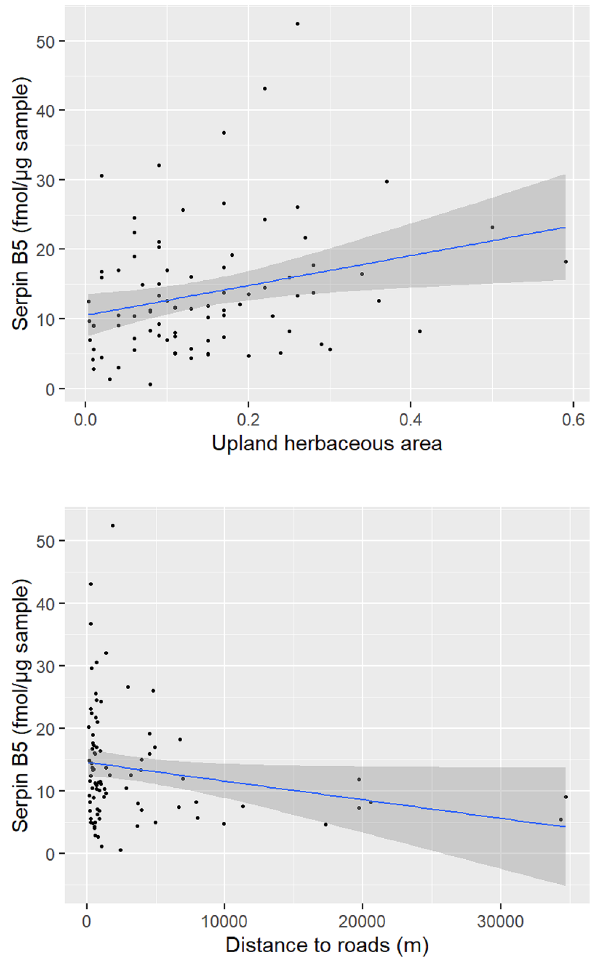
Figure 4. Estimated expression (solid blue line) of serpin B5 related to the distance to upland herbaceous area (top panel) and distance to roads (bottom panel). Grey shade is 95% confidence band and closed symbols are the raw data of protein expression. Figure was created using R statistical software version 4.0.3 and R studio version 1.3.1093 (https:// www.R- proje ct. org/).